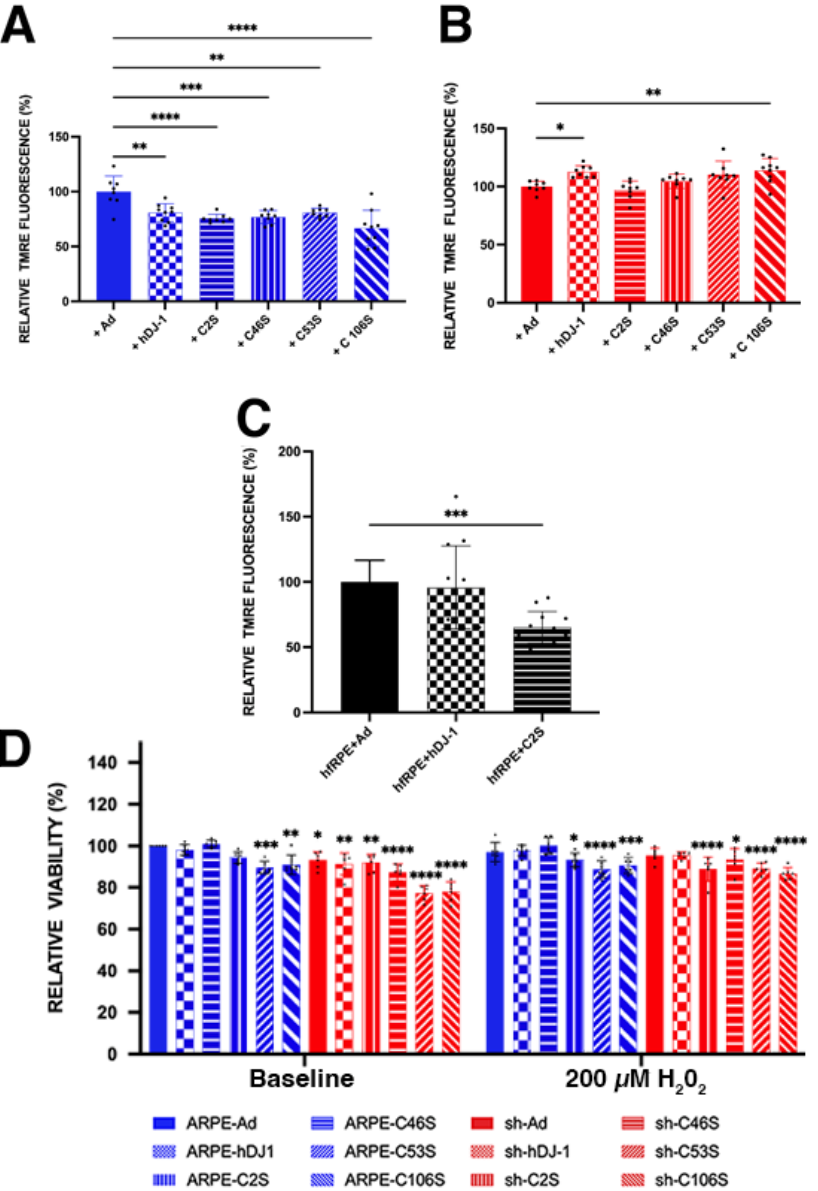
Figure 7. Transduction of ARPE-19 (blue bars), ARPE-19 + shDJ-1 (red bars), and hfRPE monolayers (black bars) with the several DJ-1 constructs displayed changes in mitochondrial membrane potential and viability. Representative TMRE fluorescence ( A – C ) and cell viability bar graphs ( D ). Data are expressed as mean ± SD; levels were normalized to ARPE-19 + Ad. * p = 0.01 to 0.05; ** p = 0.001 to 0.01; *** p = 0.0001 to 0.001; **** p < 0.0001; two-way ANOVA; n = 3. Dots inside graphs = Individual reading; asterisks above for significance.